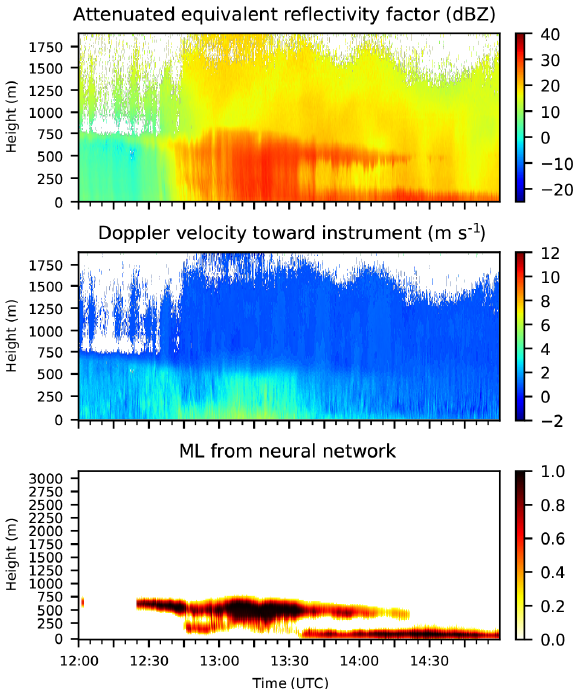
Figure 8. Same as Fig. 4 but for Hamburg on 31 March 2018 from 12:00 to 15:00UTC.